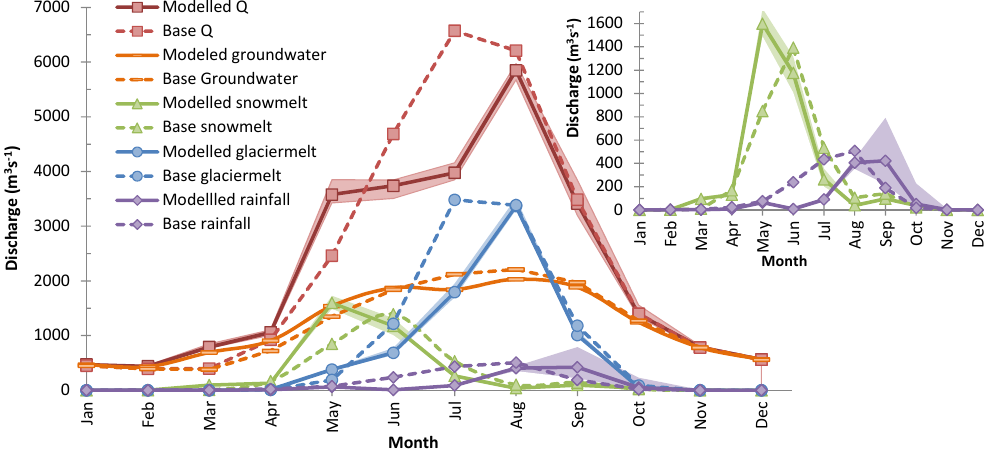
Figure 8. Results of near-future hypothetical climate change scenario (2013–2030), suggesting the continuation of prevailing climatic trends to near-future. Inset more clearly shows the snowmelt and rainfall